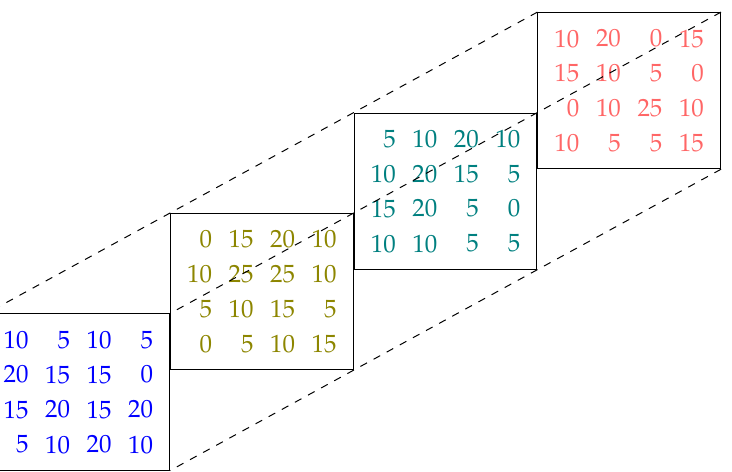
Figure 2. A sample 4-channel 3D image for I t